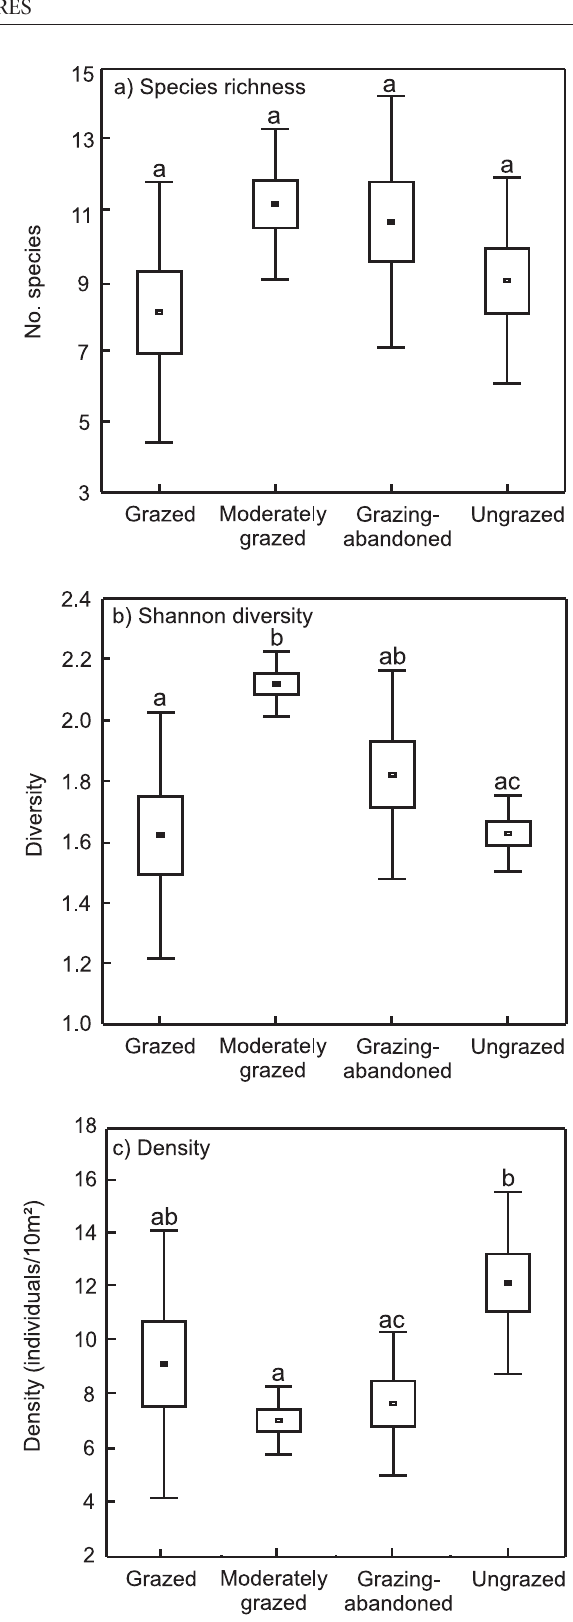
Fig. 2. Mean values (min-max and ±SE) of main parameters of orthopteran assemblages under different grazing pressure. Signifi- cant (p<0.05) differences detected by Mann-Whitney U test are indicated by different